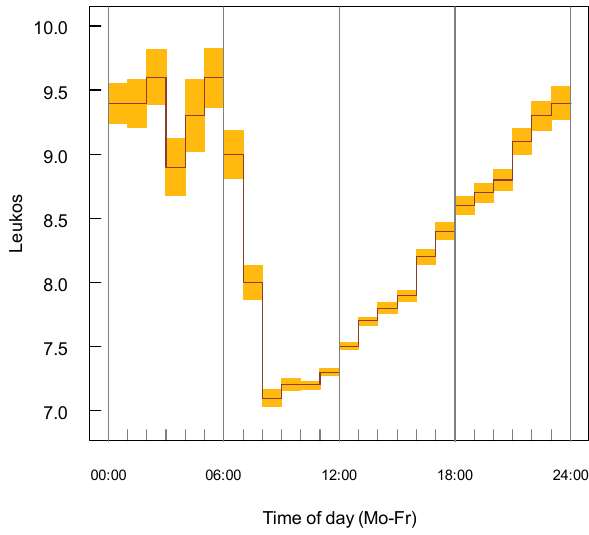
Figure 3: Diurnal variation of the leukocyte count in whole venous blood (hospitalised patients, laboratory 2, n=100,076). Daily observations are calculated during one week and the medians from Monday to Friday are presented ( × 10 9 /L). The yellow areas represent the approximate 95% con fi dence limits based on the median absolute deviation.